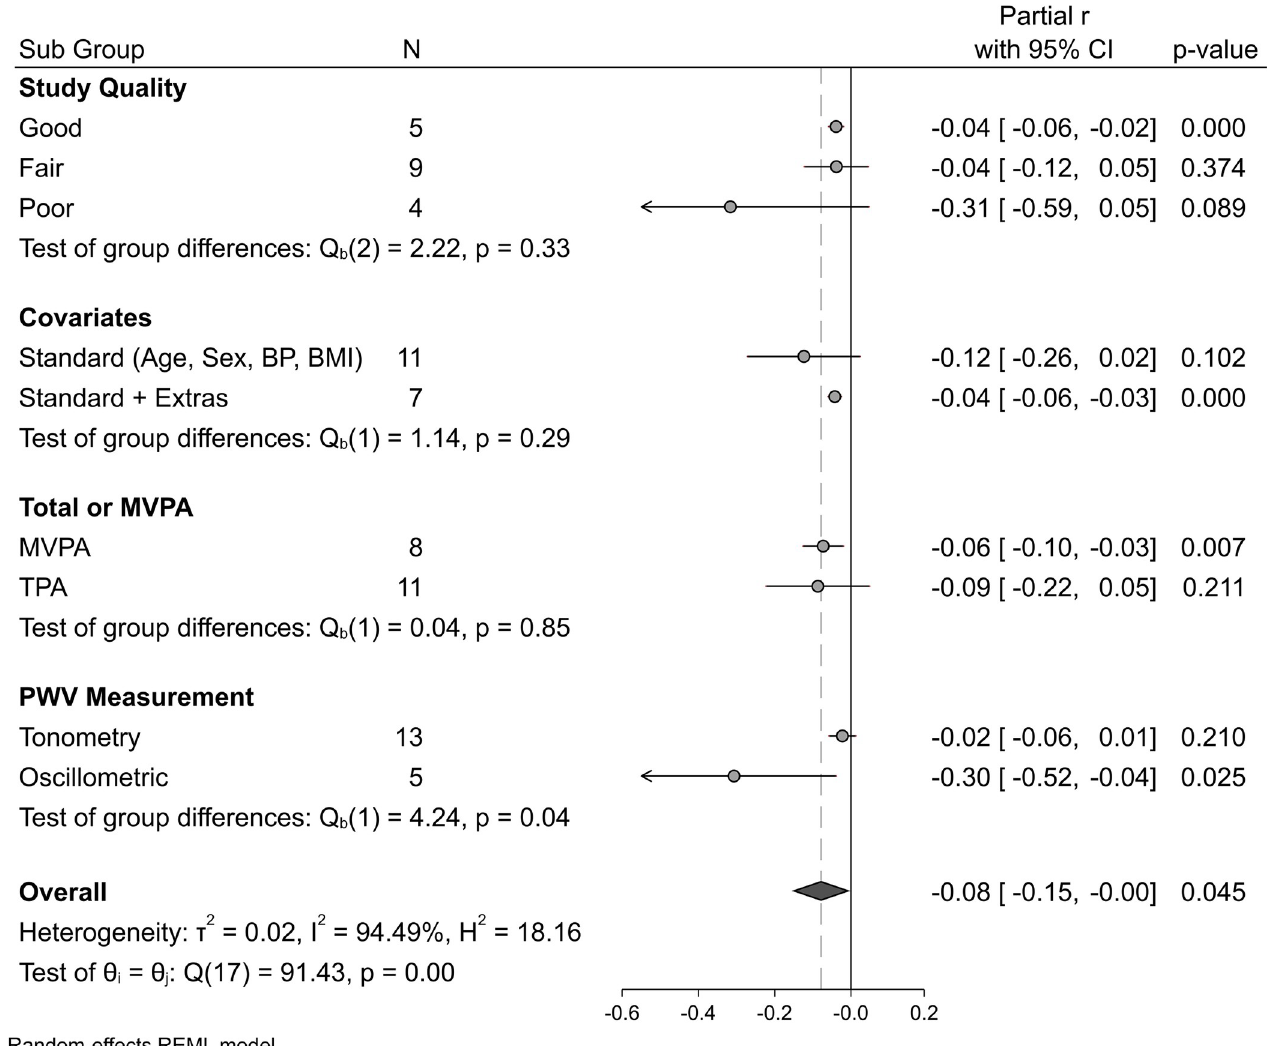
Fig 3. Sub-group summary meta-analysis indicating the association between habitual physical activity and carotid-femoral pulse wave velocity. Stratified by different subgroups: Study Quality (good vs fair vs poor), Covariates included in analysis (standard vs standard + extras), physical activity metric included in analysis (total vs moderate-vigorous PA), and the Pulse Wave Velocity measurement method (Tonometry vs Oscillometric). Random effects model. Grey circles indicate summary association estimate for each subgroup with 95% confidence intervals (CI). Solid black vertical line represents line of no difference. Dashed grey vertical line and solid grey diamond represents the overall summary estimate of association. Standard covariates includes age, sex, blood pressure and body mass index. Standard + extras covariates could include any number of additional covariates as reported within individual